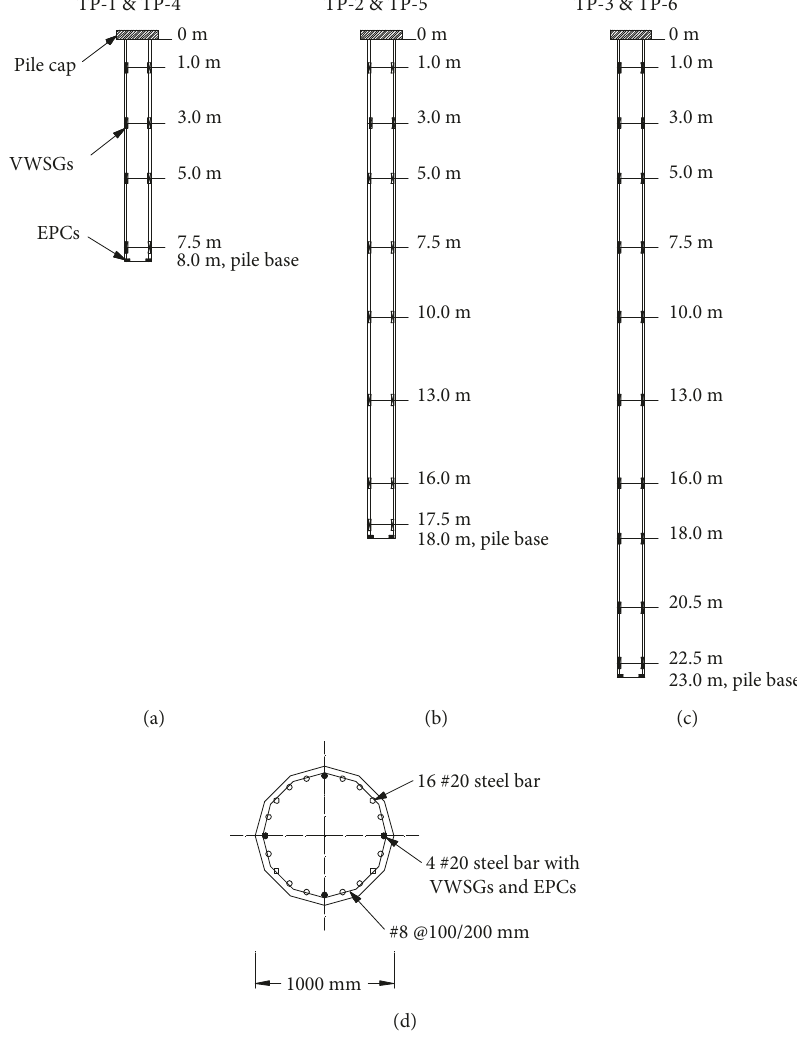
Figure 5: Sketch of the test piles.